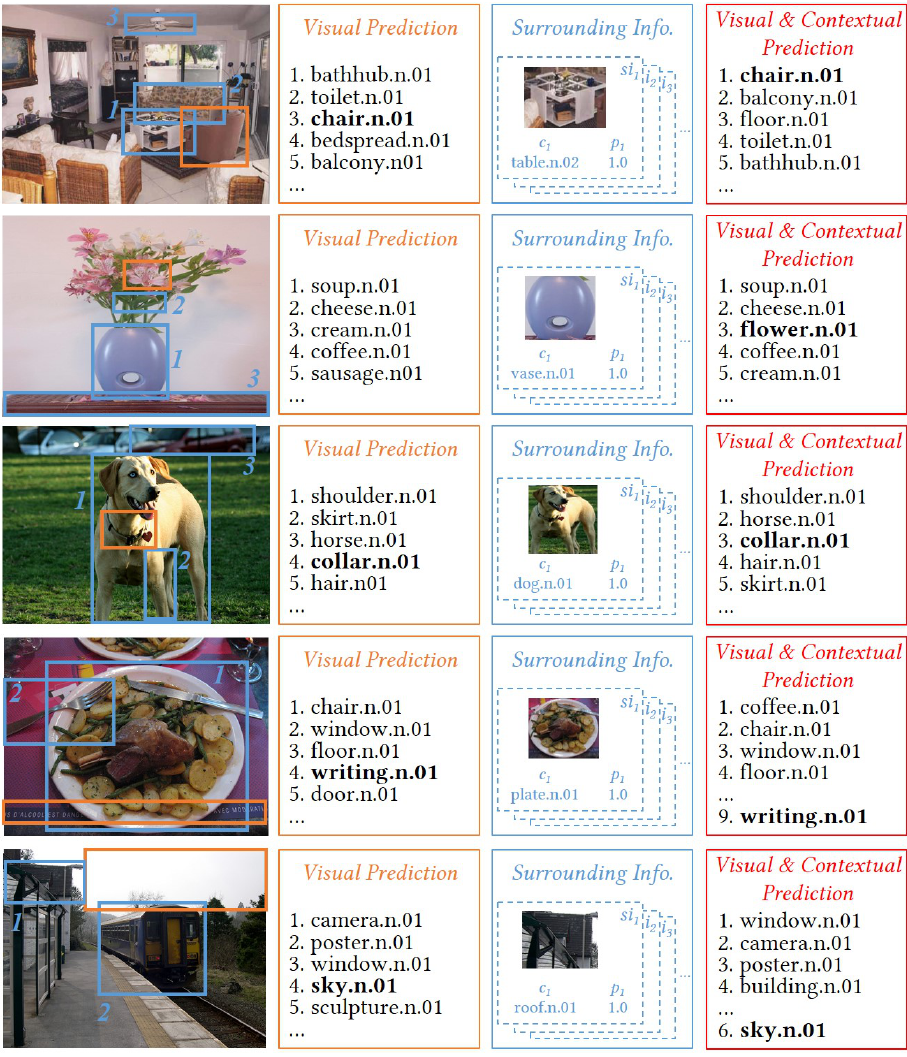
Figure 3. Qualitative examples evaluated on HM path in the classic setting using the ground-truths of seen categories instead of the pretrained detector. The orange and blue boxes indicate the target unseen objects and ground-truth surrounding objects,